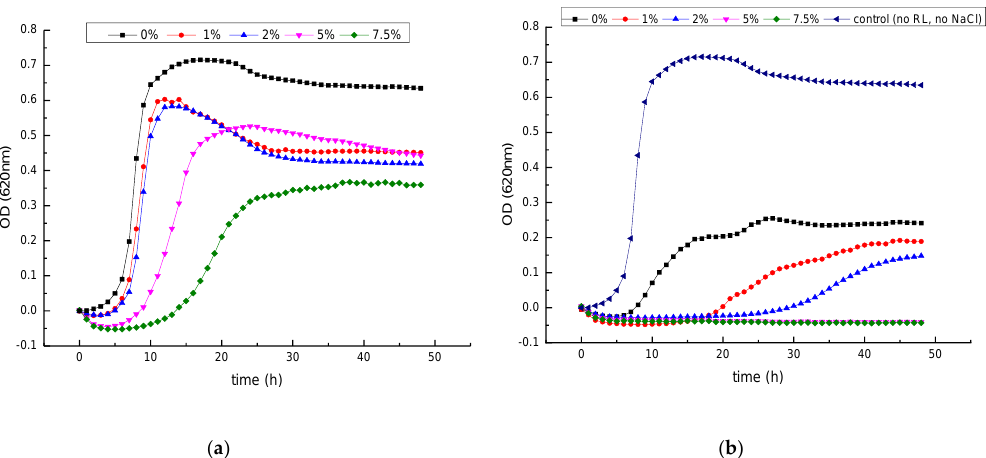
Figure 3. Growth kinetics of L. monocytogenes Scott A in BHI medium supplemented with ( a ) different concentrations of NaCl, without RL and ( b ) in combination with 500 µg/mL of RL at 30 °C. Data points represent the mean values of three replicates. Error bars have been omitted for clarity.